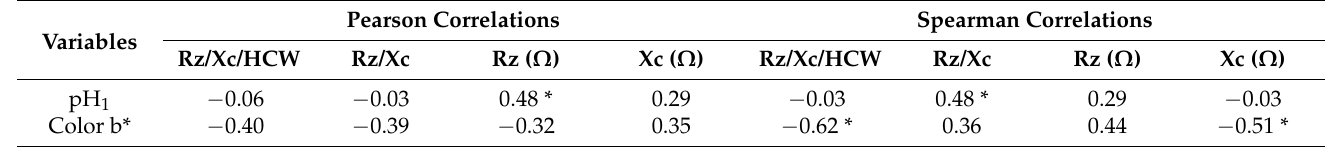
Table 2. The correlation between BIA variables and measurement meat quality traits (n = 18).